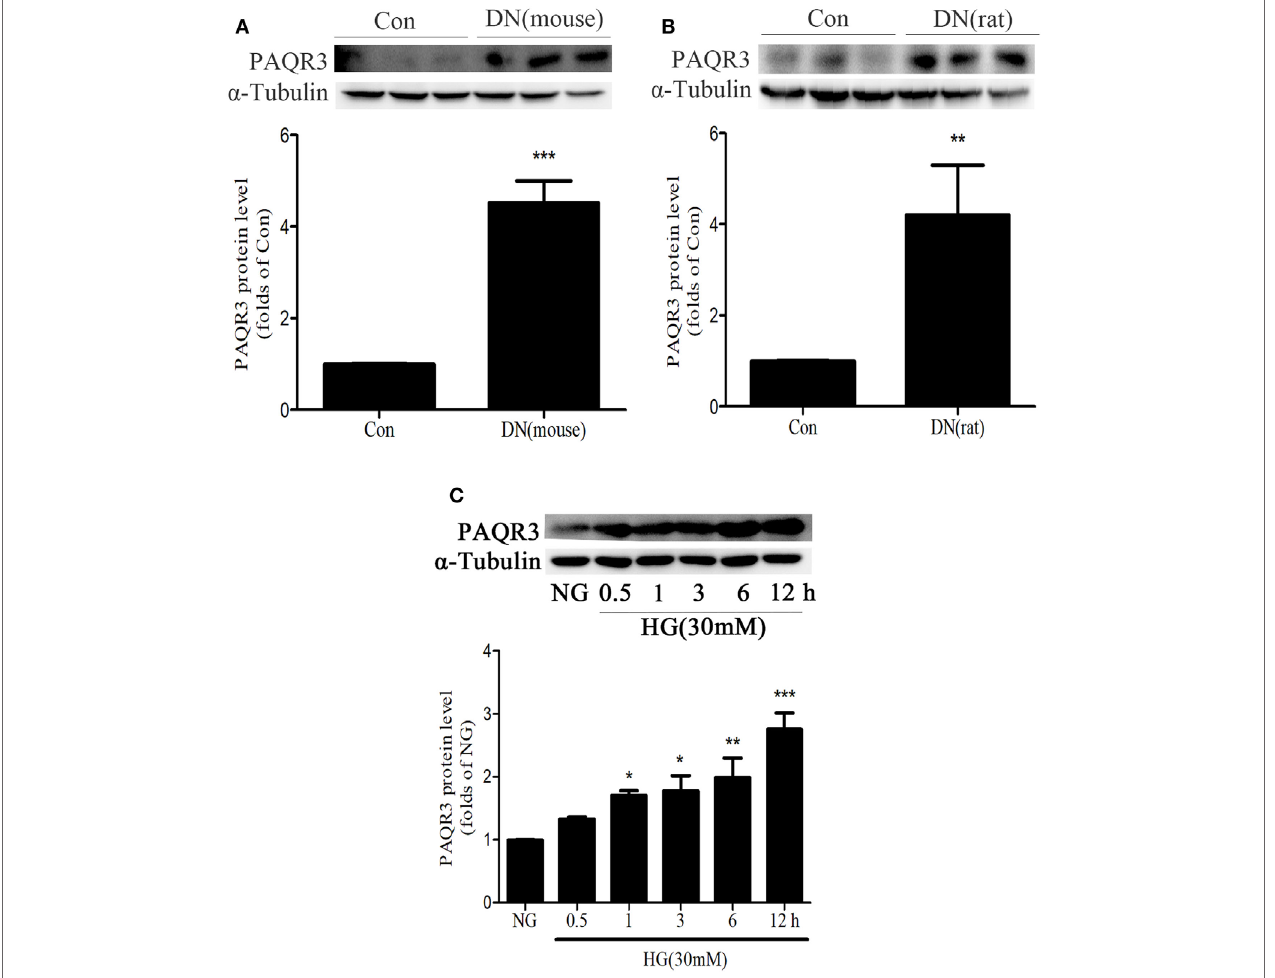
FigUre 1 | The expression of progestin and adipoQ receptor 3 (PAQR3) was upregulated in kidneys of diabetic animals or in high glucose (HG)-induced glomerular mesangial cells (GMCs). The expression of PAQR3 was assessed by Western blot in Con or the STZ-induced diabetic mice (a) and rats (B) kidneys. ** P < 0.01, *** P < 0.001 vs. Con. After treatment of GMCs with 30 mM HG, the PAQR3 protein level was raised in a time-dependent manner (0, 0.5, 1, 3, 6, and 12 h) (c) . * P < 0.05, ** P < 0.01, *** P < 0.001 vs. NG. Independent experiments were performed at least three times with similar